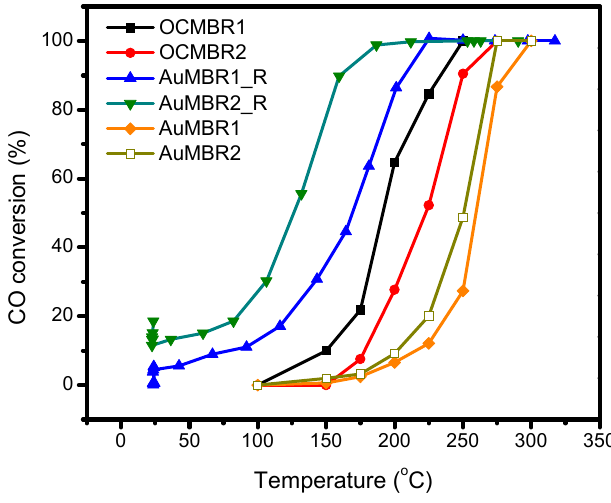
Figure 10. Comparative graph of CO conversion for OCMBR1, OCMBR2, AuMBR1_R, AuMBR2_R, AuMBR1, and AuMBR2 catalysts. (R: reduced).